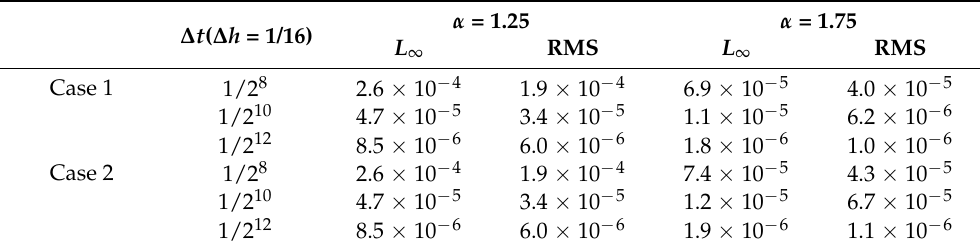
Table 6. Error norms of the wavelet solution at t = 1 with various time steps for Example 6. ∆ t ( ∆ h = 1/16) α = 1.25